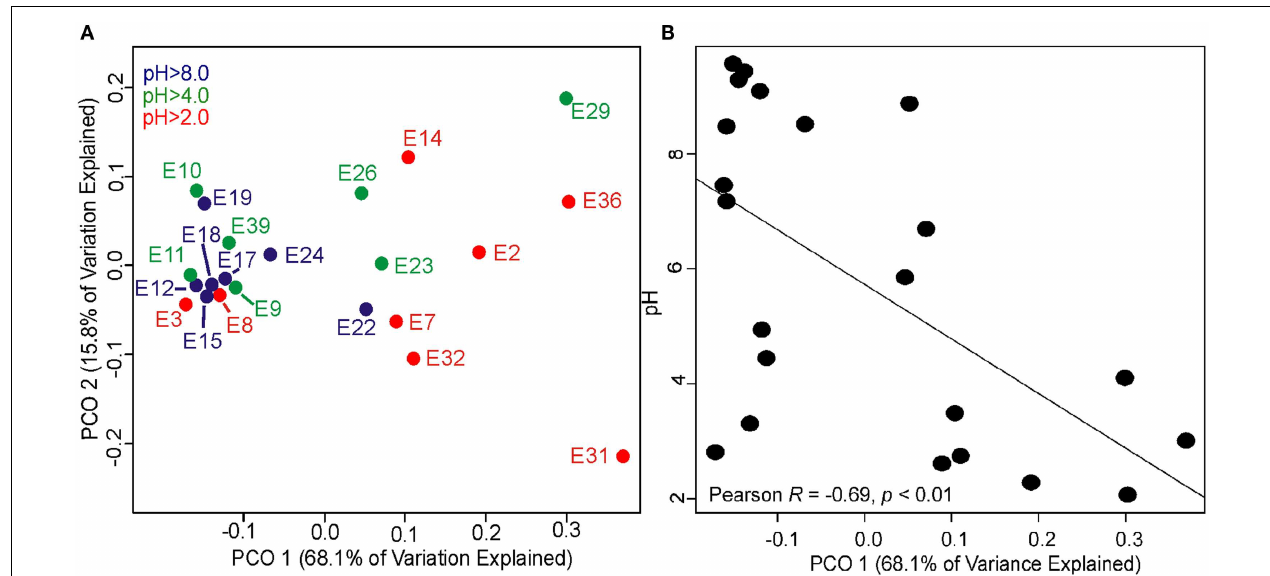
recovered is presented inTable S8 in Supplementary Material. Representative sequences for each OTU are also provided inTable S8 in Supplementary Material. Regression analysis of the top five PCO axes and geochemical variables is presented inTable S9 in Supplementary Material. Regression analysis of the top five PCO axes and C- and P-iGDGTs is presented inTables S10 and S11 in Supplementary Material, respectively.